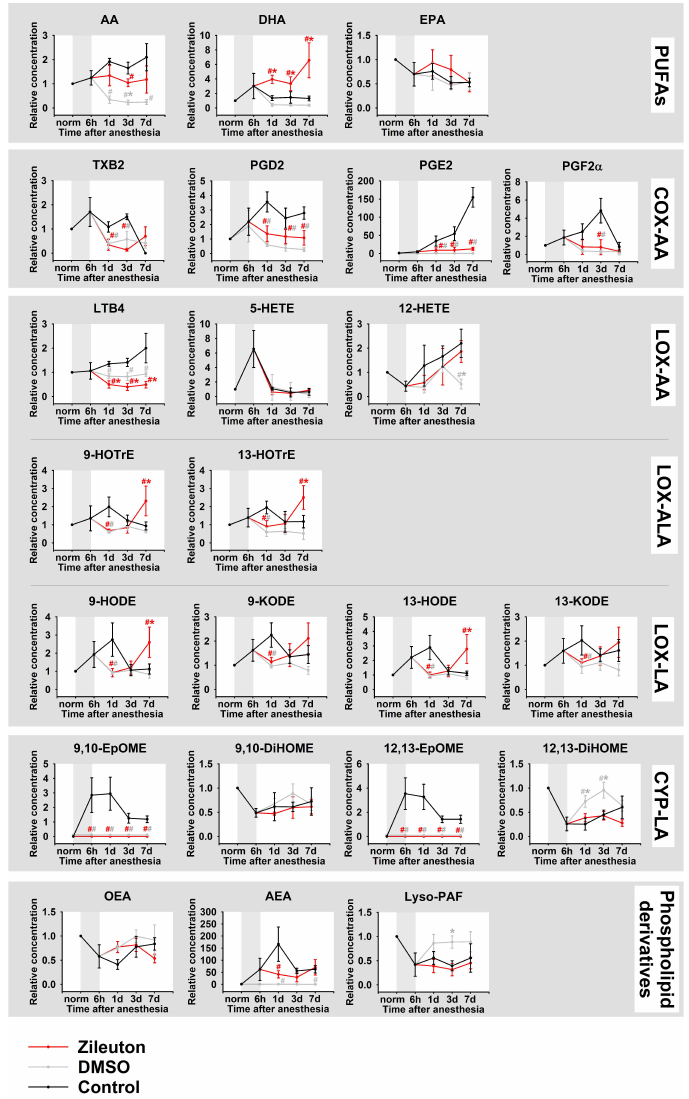
Figure 7. Dynamic changes in TF content of lipid mediators in DES in the course of anti-inflammatory therapy. The animals were exposed to general anesthesia for 6 h (shown as gray box) and subsequently received instillations of the eye drops containing 50% DMSO (gray) or 50% DMSO with 0.5% zileuton (red), one drop three times daily in each eye for 7 days. TF samples were collected before (norm) and immediately after (6 h) the general anesthesia as well as on 1, 3, and 7 day post-exposure. The concentrations of the lipid mediators (phospholipid derivatives, PUFAs and oxylipins) in TF were measured using quantitative UPLC-MS / MS analysis. # p < 0.05 as compared to parameters of TF of the untreated animals with DES (black). * p < 0.05 as compared to parameters of TF of the animals from the DMSO or zileuton